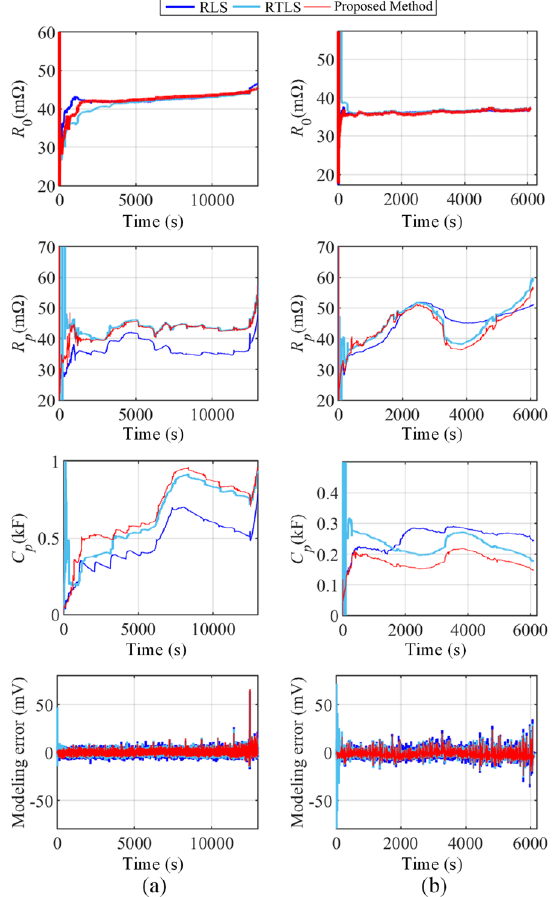
Figure 10 Experimental results of the parameter identification under different circumstances: ( a ) NEDC (10 °C), ( b ) FTP (10 °C)